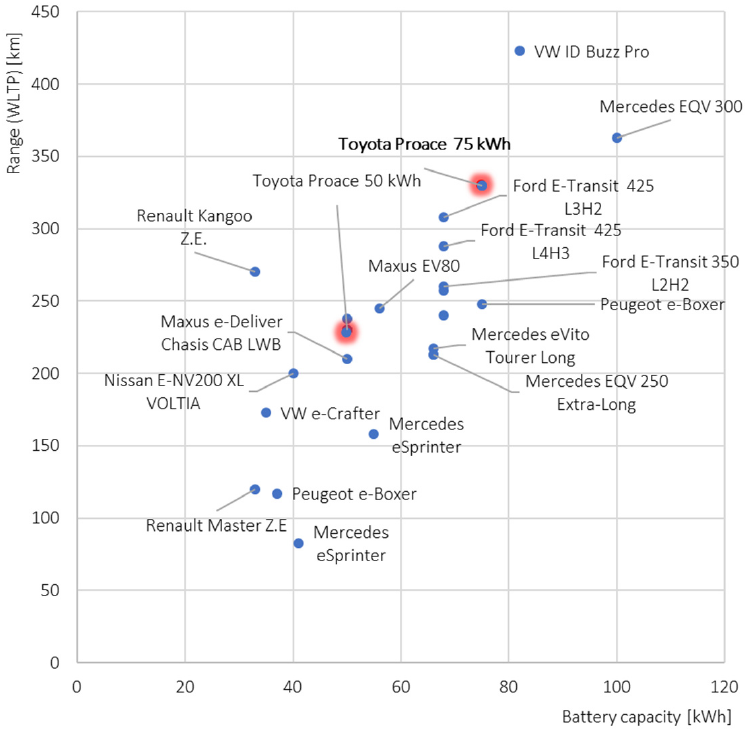
Figure 4. List of battery capacities of an electric LDV available on the Polish market, combined with their catalogue range based on the WLTP test [31] (marked with a red, color two versions of the test vehicle varying in battery capacity).